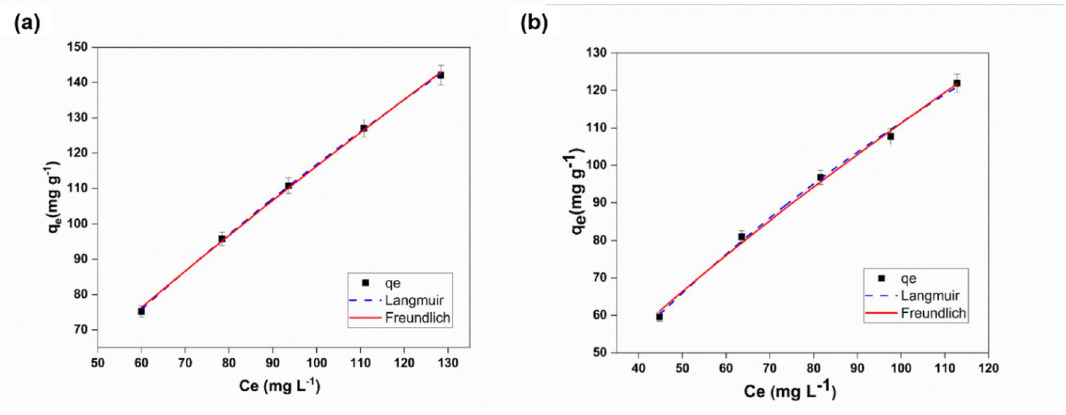
Figure 7. Equilibrium curves of Langmuir and Freundlich isotherm model for ( a ) Cd(II), and ( b ) Pb(II) adsorption onto SP-5 ENMs. [Metal (Csubs0 = 0.2 mg L −1 , pH = 7, 2 h, and at room temperature.